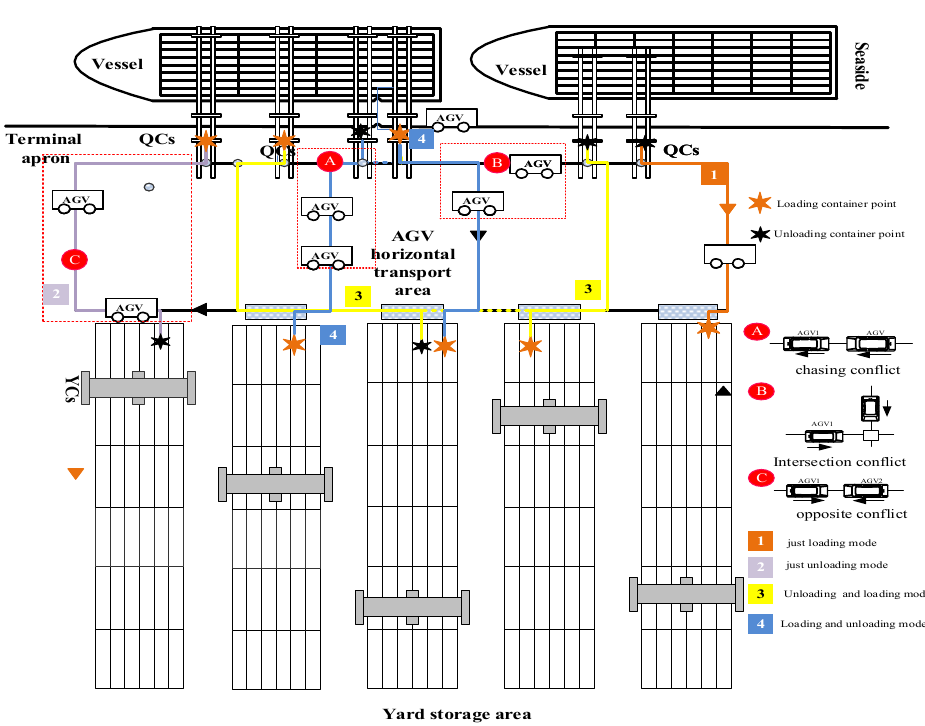
Figure 1. Layout diagram of automated container terminal.